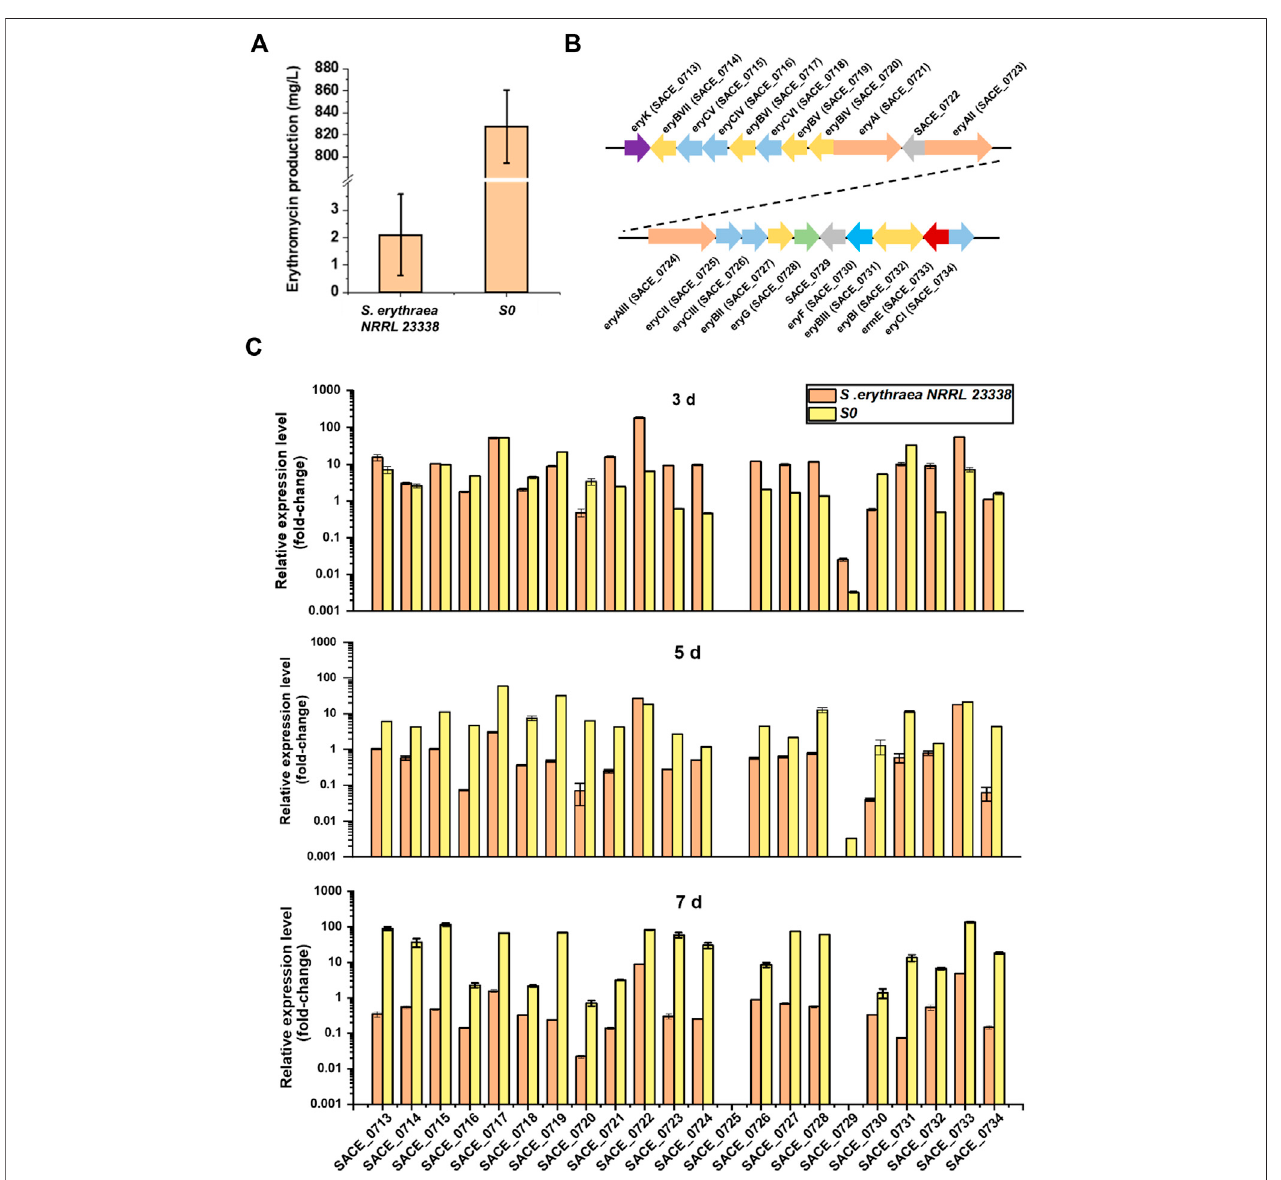
FIGURE4| ComparativeqRT-PCRanalysisof ery genesinthelow-producing strain S.erythraea NRRL23338and thehigh-producingstrainS0. (A) Erythromycin productions of S. erythraea NRRL 23338 and S0 after 7-days cultivation in 24-well-plate. (B) Schematic representation of erythromycin biosynthetic gene cluster ( ery ). (C) Relativeexpressionlevelsof ery genesin S.erythraea NRRL23338andS0atday3,day5andday7.Theverticalaxiswasthelogarithmicaxis.Errorbarsrepresented the standard deviation of three experiments.